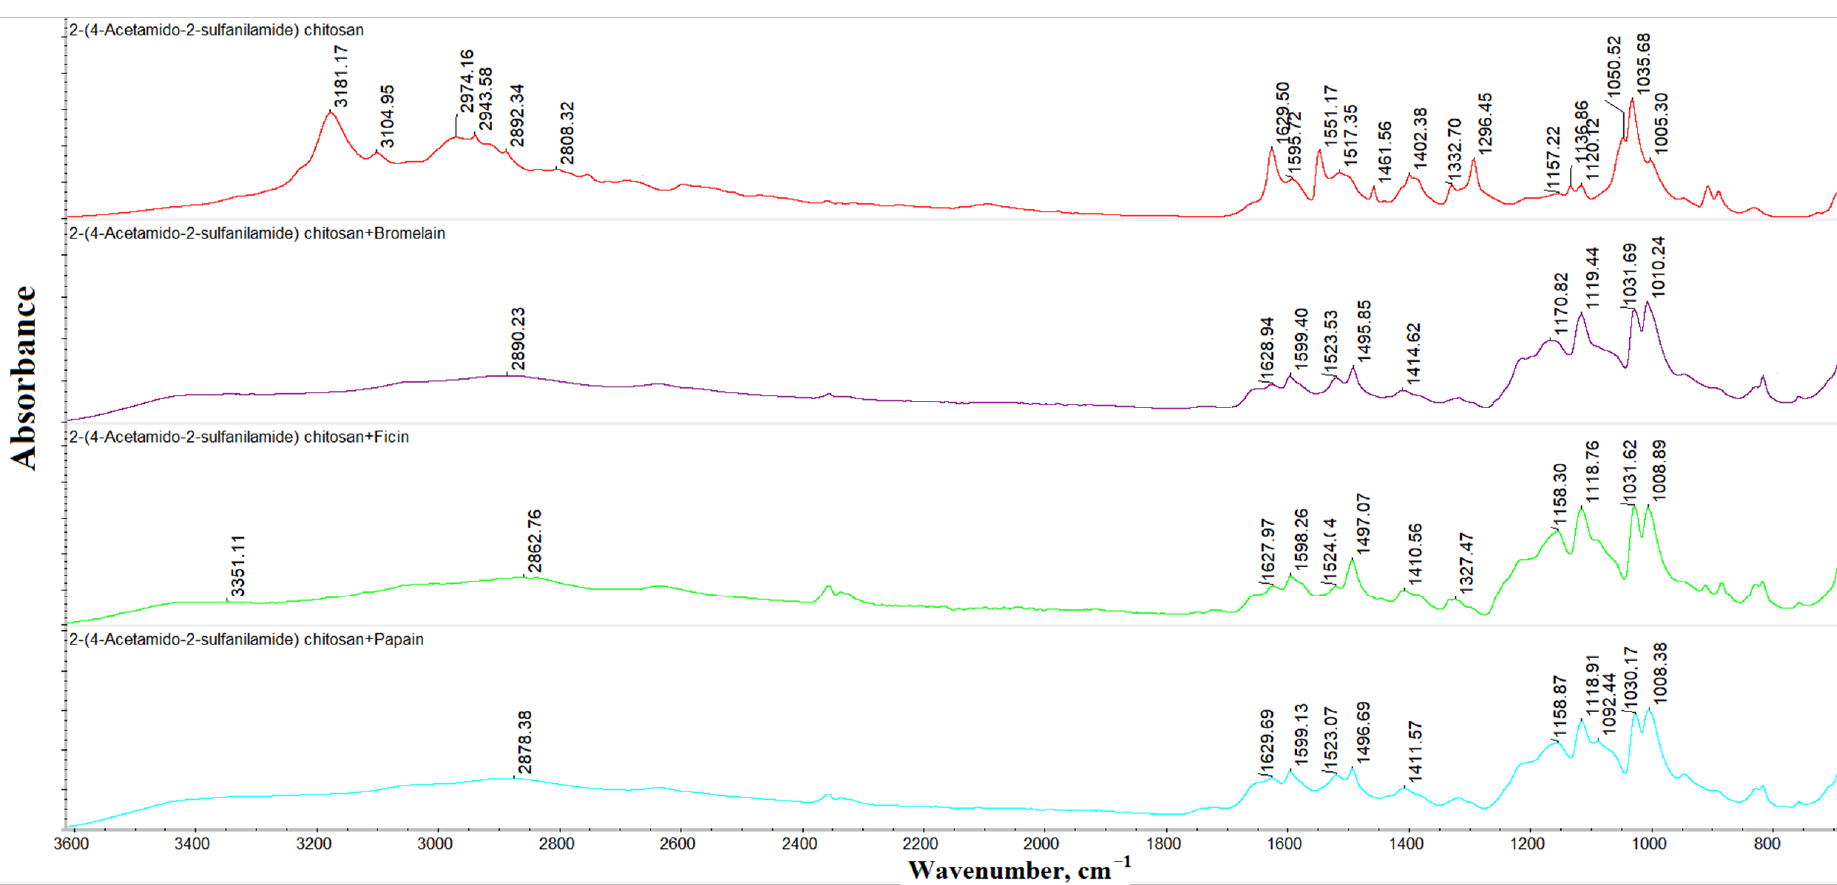
Figure 1. The FTIR spectra of 2-(4-acetamido-2-sulfanilamide) chitosan and the immobilized